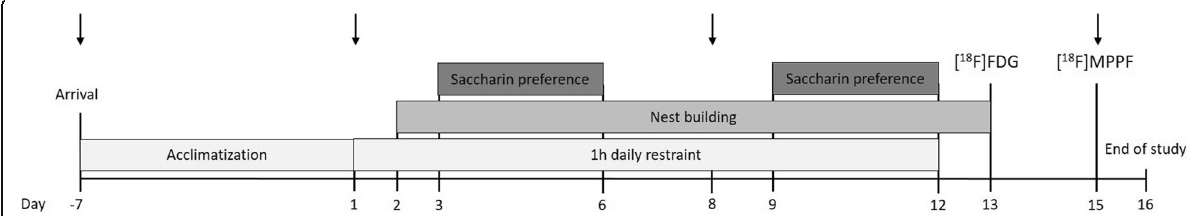
Fig. 1 Timeline of study. The black arrow indicates the cage changes with new bedding and nesting